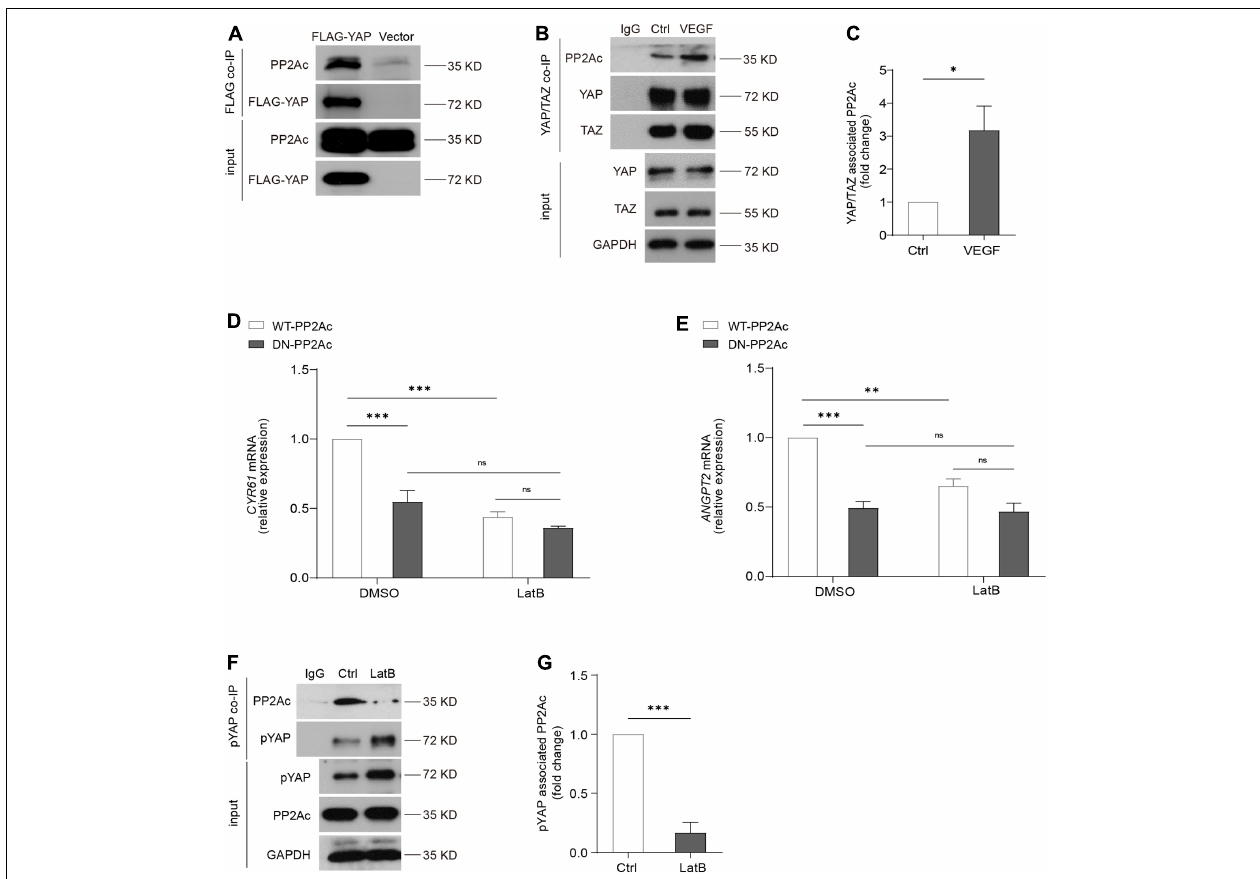
FIGURE 6 | Cytoskeleton dynamics is required for PP2A and YAP interaction. (A) HEK293T cells were transfected with a control plasmid or a plasmid encoding Flag-YAP. Cell lysate were incubated with anti-Flag affinity beads and eluted with 3X-Flag peptide. Representative blots of this co-Immunoprecipitation (co-IP) showed PP2Ac as an interacting protein with Flag-YAP. (B) Representative blots of the co-Immunoprecipitation (co-IP) of endogenous YAP/TAZ and PP2Ac in HUVECs stimulated with 50 ng/mL VEGF for 2 h. (C) Quantification of co-IP shown in (B) . n = 3 independent experiments. (D,E) HUVECs were infected with WT-PP2Ac or DN-PP2Ac adenovirus for 36 h, followed by LatB (0.05 µ g/mL) treatment for 6 h. The expression of YAP target genes CYR61 and ANGPT2 were analyzed by qPCR. (F) Representative blots of the co-Immunoprecipitation (co-IP) of pYAP and PP2Ac in HUVECs treated with LatB for 2 h. (G) Quantification of co-IP shown in (F) . n = 3 independent experiments. Data are shown as mean ± SEM, one-way ANOVA followed by Tukey’s multiple comparisons test in (D,E) , two tailed Student’s t -test in (C,G) . ∗ p < 0.05, ∗∗ p < 0.01, ∗∗∗ p < 0.001, ns indicates not significant.